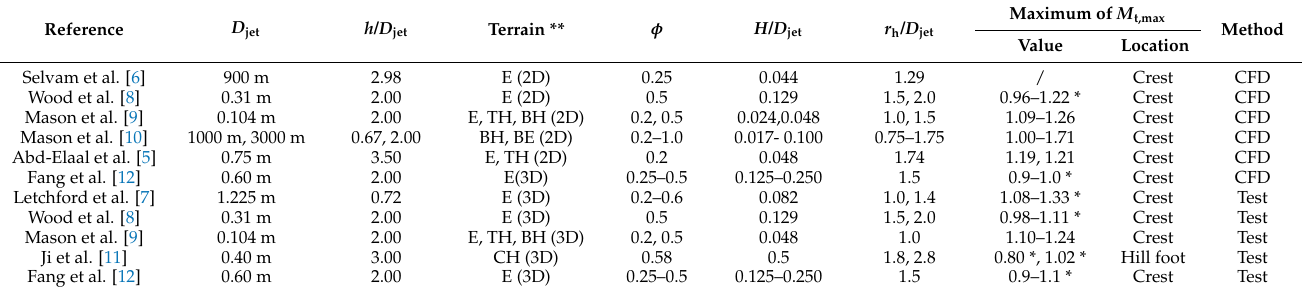
Table 1. Selected topographic multipliers in the